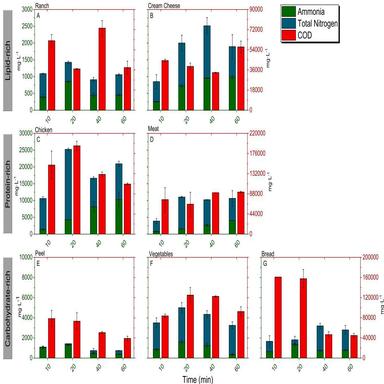
Distribution of total nitrogen, ammoniacal nitrogen, and chemical oxygen demand across range of HTL reaction times for the different feedstocks. Lipid-rich, Protein-rich, and Carbohydrate rich feedstocks are arranged in the top, middle, and bottom rows, respectively (Total Nitrogen = Blue and Ammoniacal Nitrogen = Green, both corresponding to the left y-axis, while COD = Red, corresponding to the right y-axis).